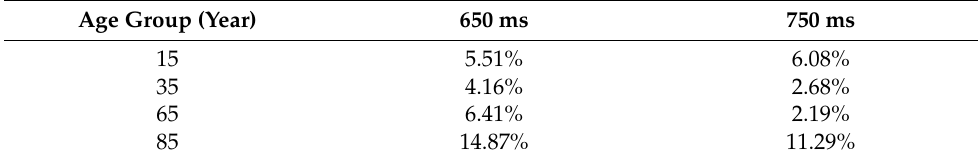
Table 1. Relative L 2 -errors of reconstructed pulse wave.